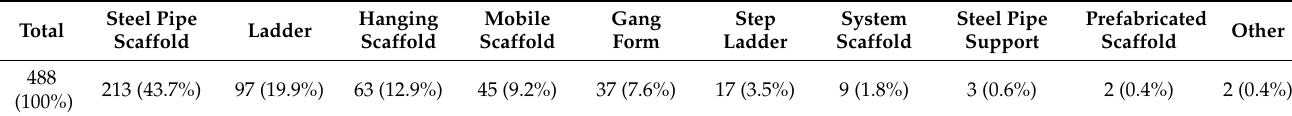
Table 2. Accident status by type of scaffold.